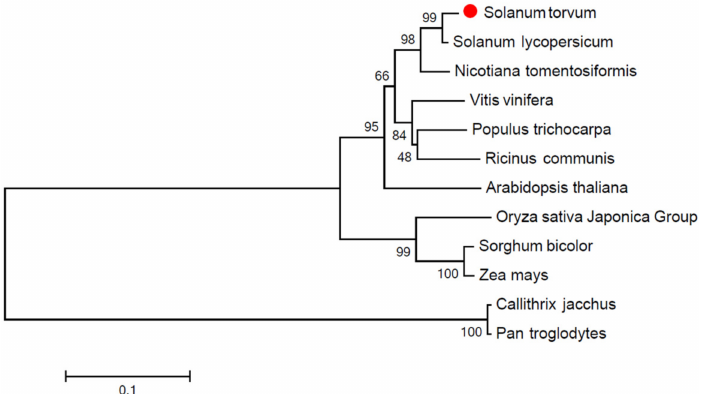
Figure 4. Phylogenetic analysis of StPP5. The Stpp5 were highlighted with the red circle. Source and accession number of PP5: Vitis vinifera (XP_002280111), Zea mays (NP_001150042), Arabidopsis thaliana (NP_001031534), Callithrix jacchus (XP_002762302), Pan troglodytes (XP_512768), Ricinus com- munis (XP_002520400), Populus trichocarpa (XP_024441018), Sorghum bicolor (XP_002439438), Oryza sativa Japonica Group (XP_015637335), Nicotiana tomentosiformis (XP_009603851), Solanum lycopersicum (AAN64317), and Solanum torvum